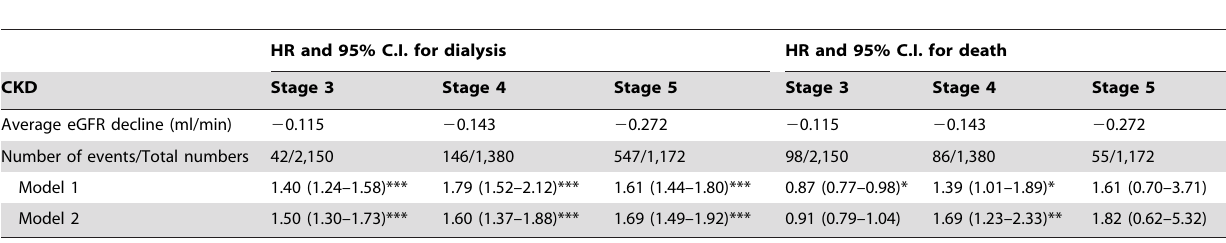
Table 4. Association of eGFR decline with dialysis and death in CKD stages 3 , 5 cohort using univariate and multivariate cox proportional hazards